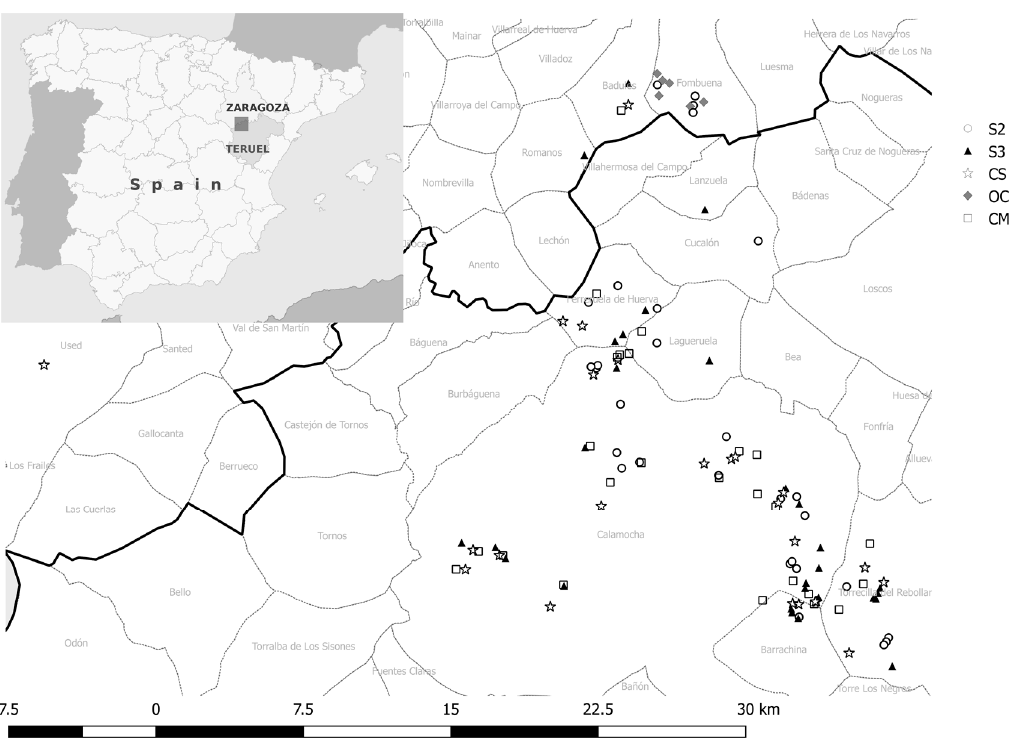
Figure 1. Map showing the surveyed fields. S2: sainfoin in the second year, S3: sainfoin in the third year, CS: sainfoin after cereal, OC: organic cereal, CM: cereal monocrop. The rest of OC fields were located in Fuentes Calientes, approximately 20 km south and are not included in the Figure to facilitate